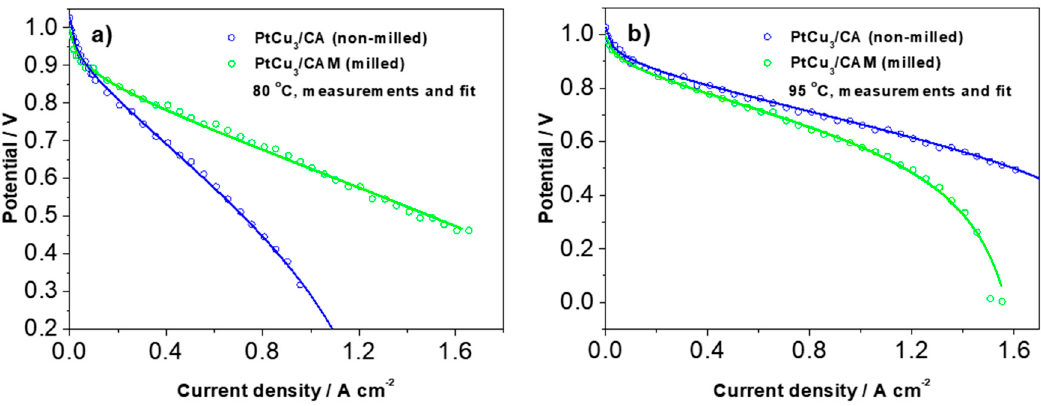
Figure 6. Examples of fits of experimental curves at ( a ) 80 °C and ( b ) 95 °C with the analytical solution by Kulikovsky [33]. The values of fitted parameters and their physical meaning is shown in Supplementary Table S3.